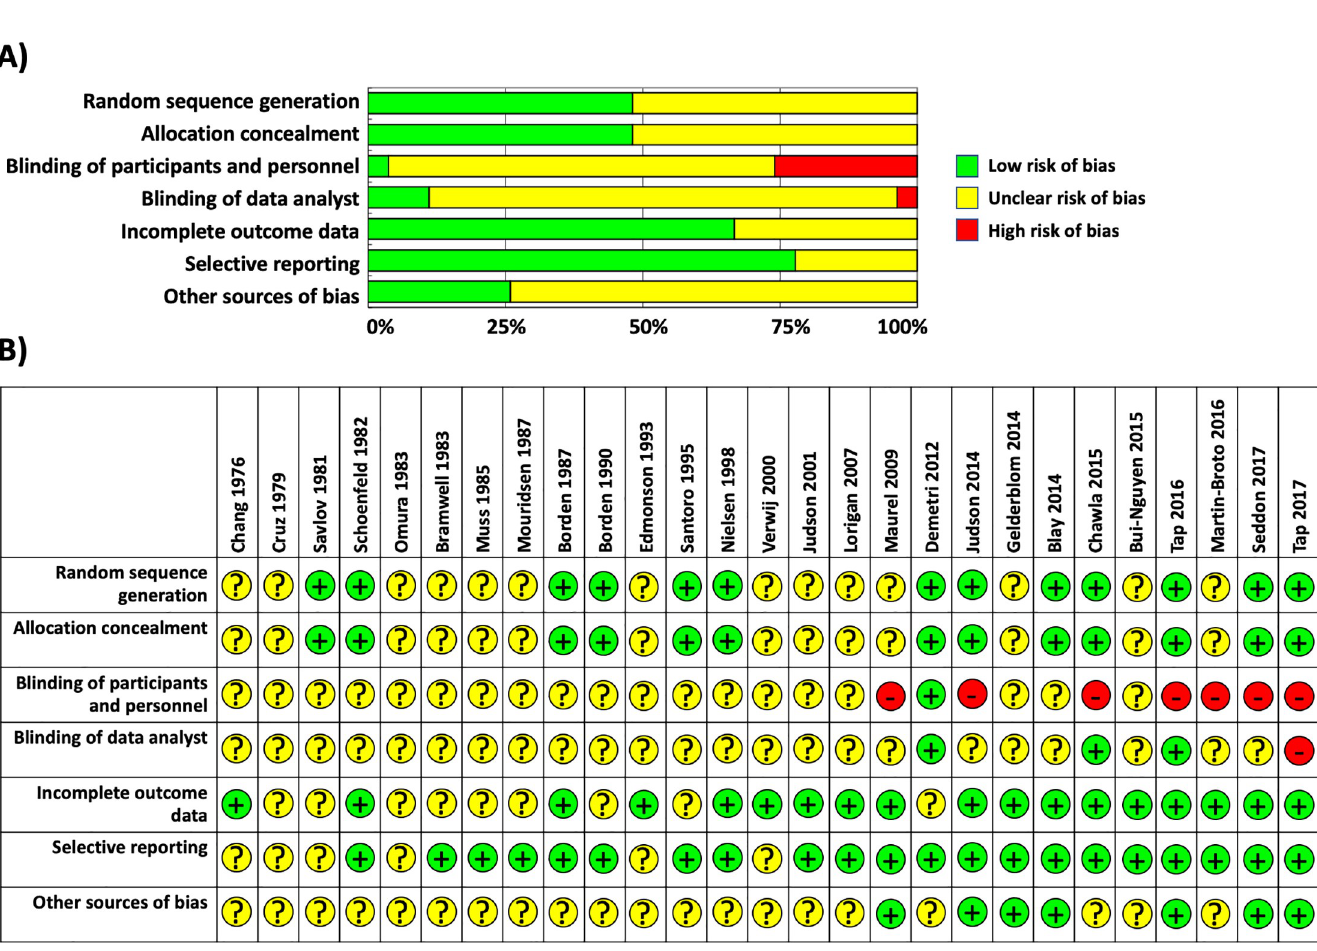
Fig 2. Assessment of the risk of bias of the included studies. (A) Risk of bias graph. (B) Risk of bias summary.